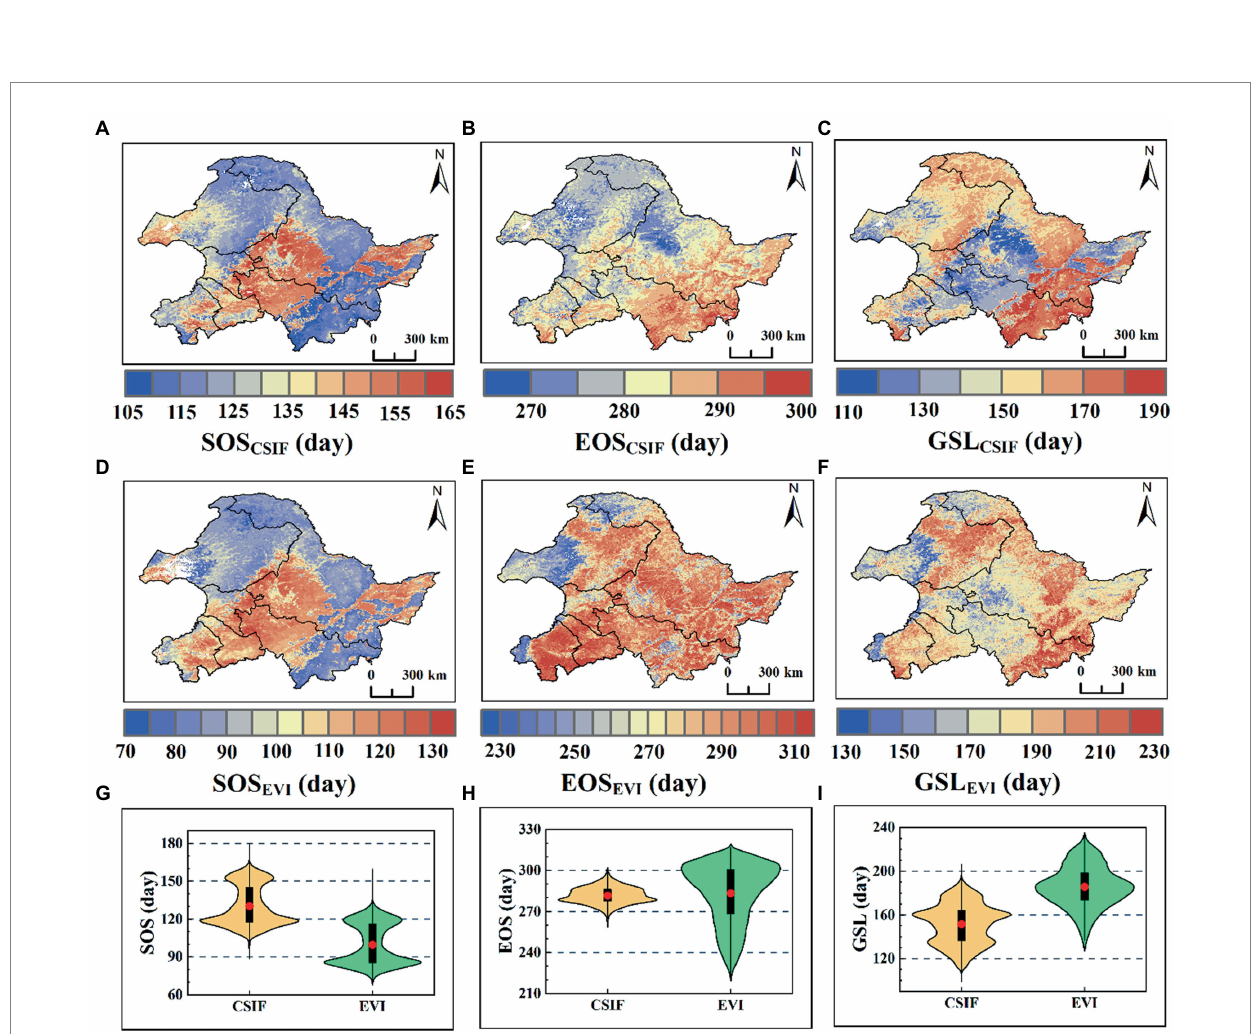
FIGURE 3 Spatial patterns of SOS, EOS and GSL means based on DL extracted CSIF and EVI datasets. (A–C) Spatial patterns of SOS, EOS, and GSL derived CSIF; (D–F) Spatial patterns of SOS, EOS, and GSL derived EVI; (G–I) Violin plots, where red dots indicate means, black rectangular boxes cover the interquartile range, and thin black lines reach the 5th and 95th